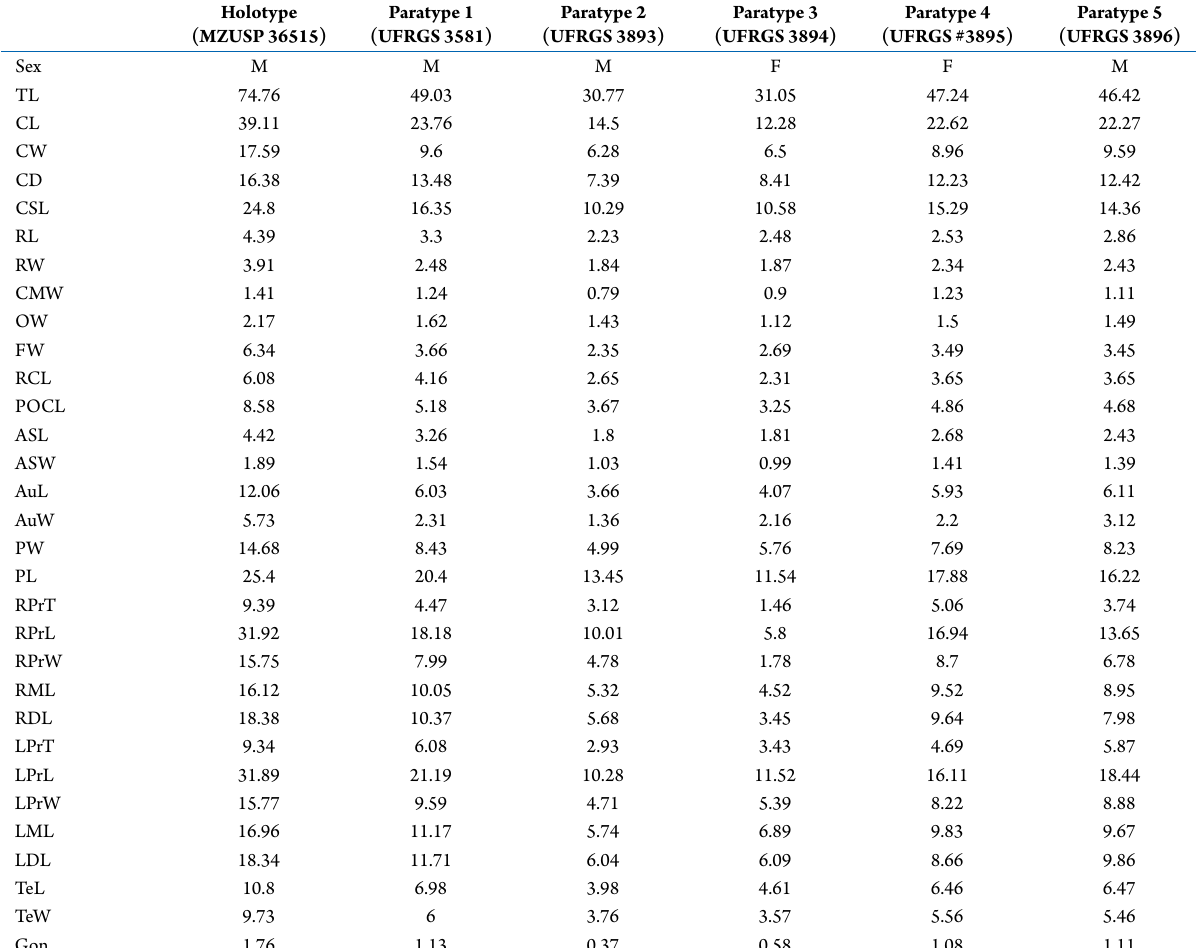
Table 1. Measurements (mm) of the type series of Parastacus buckupi sp. nov. For abbreviations see Material and Methods